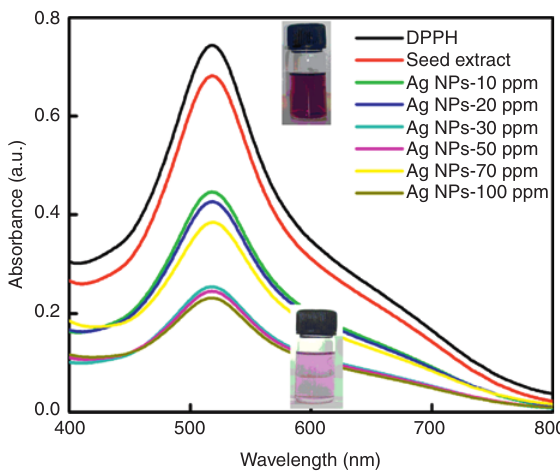
Figure 8: 2,2-Diphenyl-1-picrylhydrazyl (DPPH) extinction responses of plant extract and silver nanoparticles (AgNPs) at different concentrations.